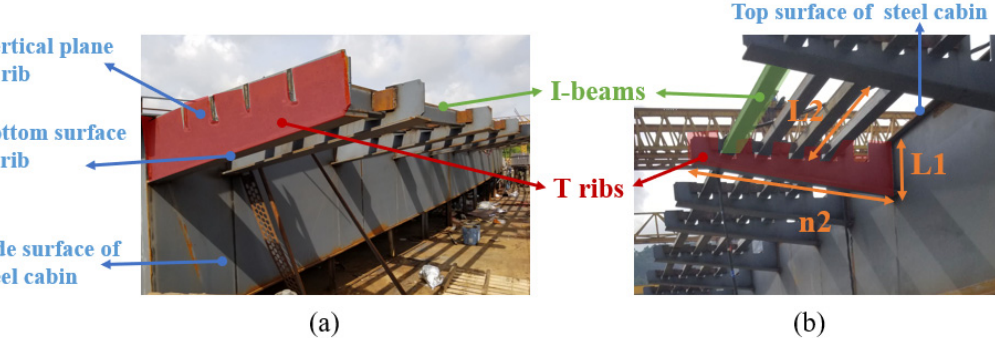
Figure 2. SBG components: ( a ) composition of steel cabin and ribs; ( b ) geometric quality inspection